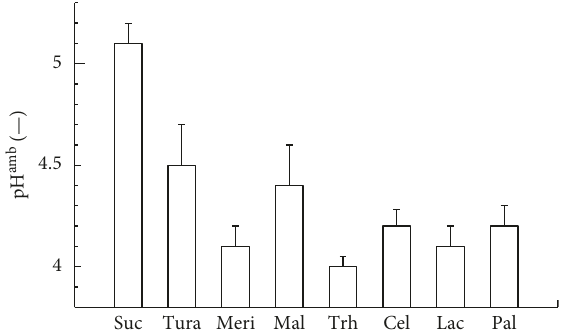
Figure 4: Specific pH value to progress the decomposition reaction of disaccharides. Suc: sucrose; Tura: turanose; Meri: meribiose; Mal: maltose; Trh: trehalose; Cel: cellobiose; Lac: lactose; Pal: palatinose. Error was calculated from the three independent experiments.